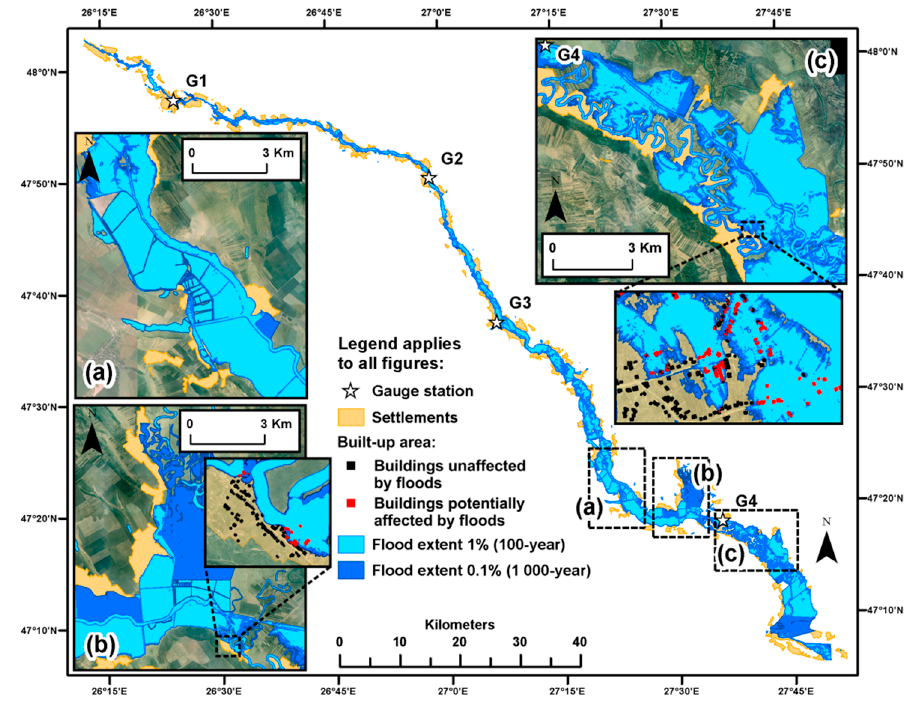
Figure 5. Flood extent derived from the 1D HEC-RAS modeling based on LiDAR data (0.5 m spatial resolution) and Q max . (m 3 /s) flow rates with 1% (100-year) and 0.1% (1000-year) recurrence intervals estimated for each gauging station (G1, G2, G3, and G4). Significant differences between 1% (100-year) and 0.1% (1000-year) flood extents are highlighted in the sections ( a – c ). Table 2. Flood extent area and number of buildings potentially affected by floods computed for each 1% (100-year) and 0.1% (1000-year) recurrence interval scenarios using 1D HEC-RAS modeling. Flood Extent 1% (100-year) 0.1% (1000-year) 1 Differences Total flood extent (km 2 ) 195.92 251.82